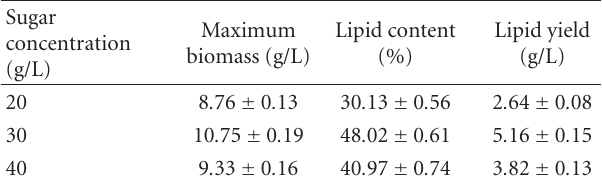
Table 3: E ff ects of sugar concentration on microbial oil production by Y. lipolytica